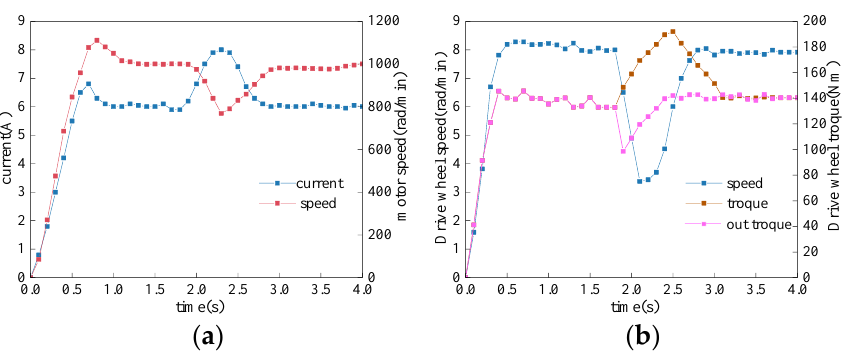
Figure 9. System sliding modulation algorithm under the control of an abrupt load curve. ( a ) Motor speed and current. ( b ) Drive wheel speed and torque.